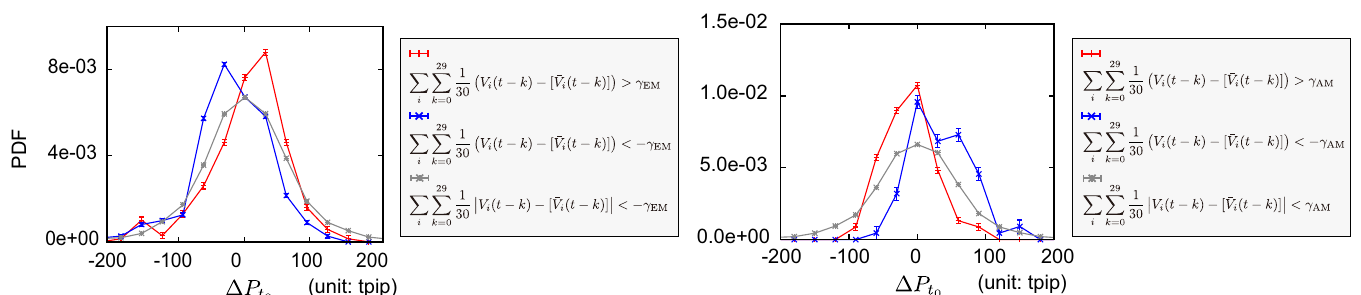
Fig 7. Conditional distributions of market mid-price changes fifteen minutes after the observation of unbalanced positions in banks following either EM or AM strategies aggregated over the past thirty minutes. The EM strategy is depicted in the left panel, and the AM strategy is depicted in the right panel. In the prediction P 29 analysis, the basic time unit is a minute. When V i ð t (cid:0) k Þ (cid:0) ½ � V i ð t (cid:0) k Þ� = 30 aggregated over the banks following EM or AM strategies respectively is more (less) than k ¼ 0 the threshold values γ EM or γ AM (- γ EM or - γ AM ), the distributions are depicted by red (blue) lines. When they are in-between, they are depicted by grey lines. The sampling condition used to detect an unbalanced position is ( γ EM , γ AM ) = (8,6). The average price changes in the distributions depicted by red, blue, and grey lines, respectively, are 4.3 ± 3.6, − 18.0 ± 2.8, and 1.3 ± 0.8 tpip for the EM strategy, and − 11.5 ± 2.9, 33.0 ± 4.7, and 0.3 ± 0.8 tpip for the AM